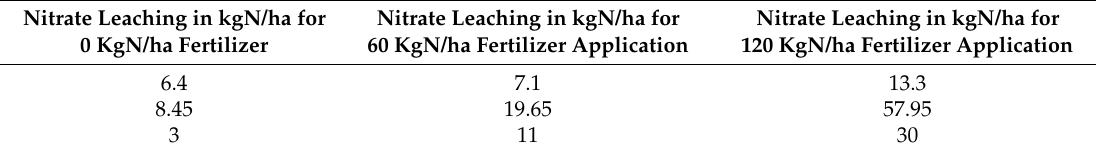
Table 2. Nitrate Leaching through Miscanthus fields (data taken from Behnke et al. [35] and Christian and Riche